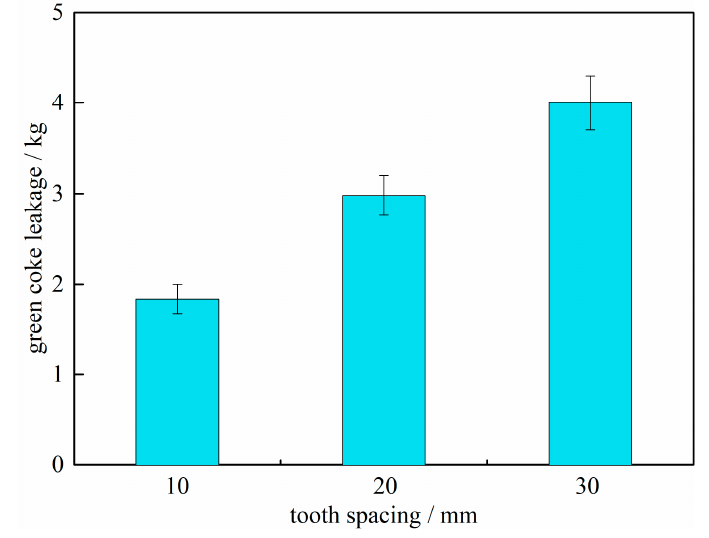
Figure 10. Relationship between green coke leakage and tooth spacing.